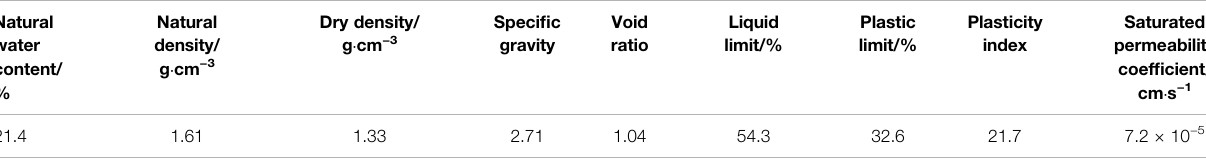
TABLE 1 | Physical properties of residual soil.